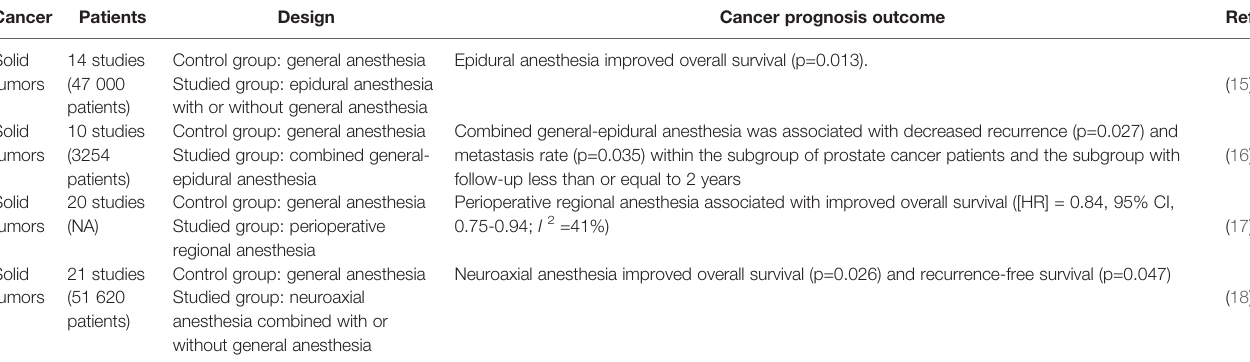
TABLE 3 | Meta-analyses assessing local anesthetics impact on cancer prognosis. Patients